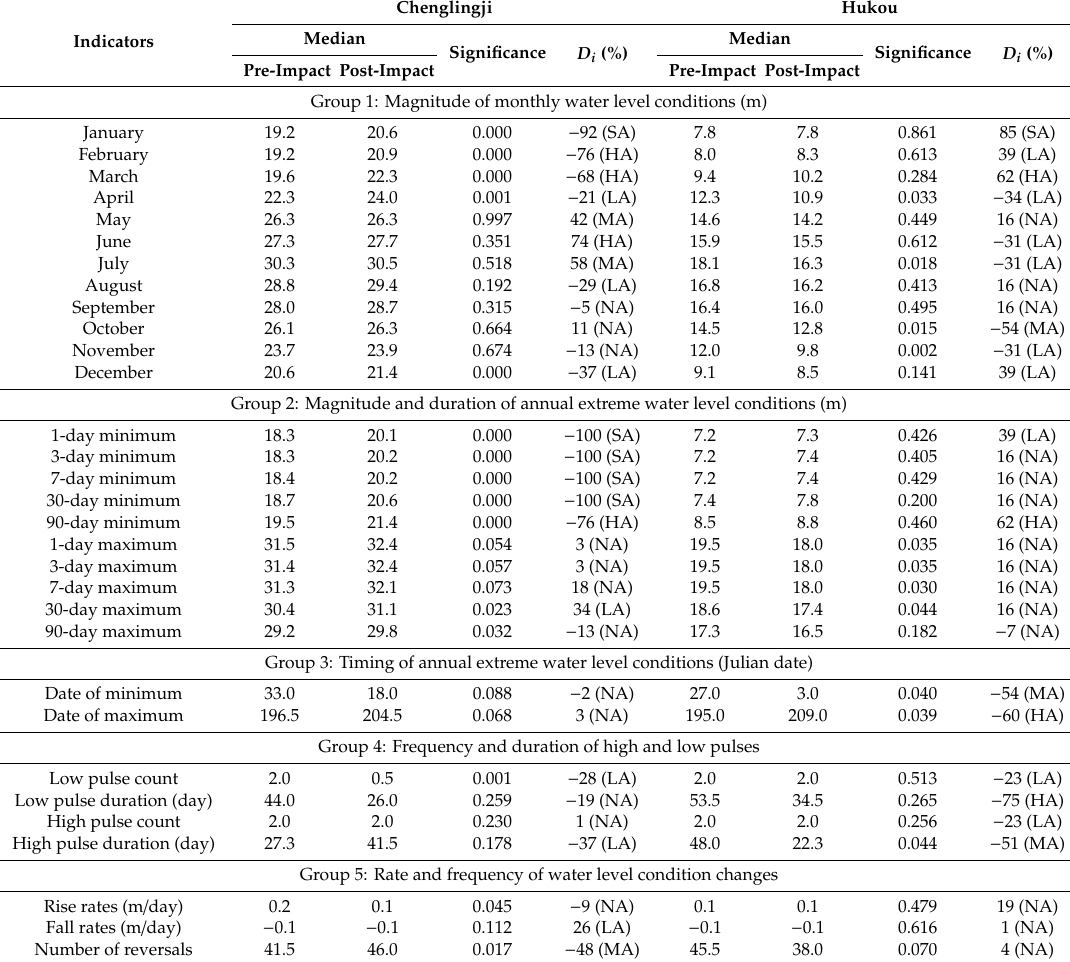
Table 4. Median values of water level in two periods and the degree of hydrologic alteration ( D i ).